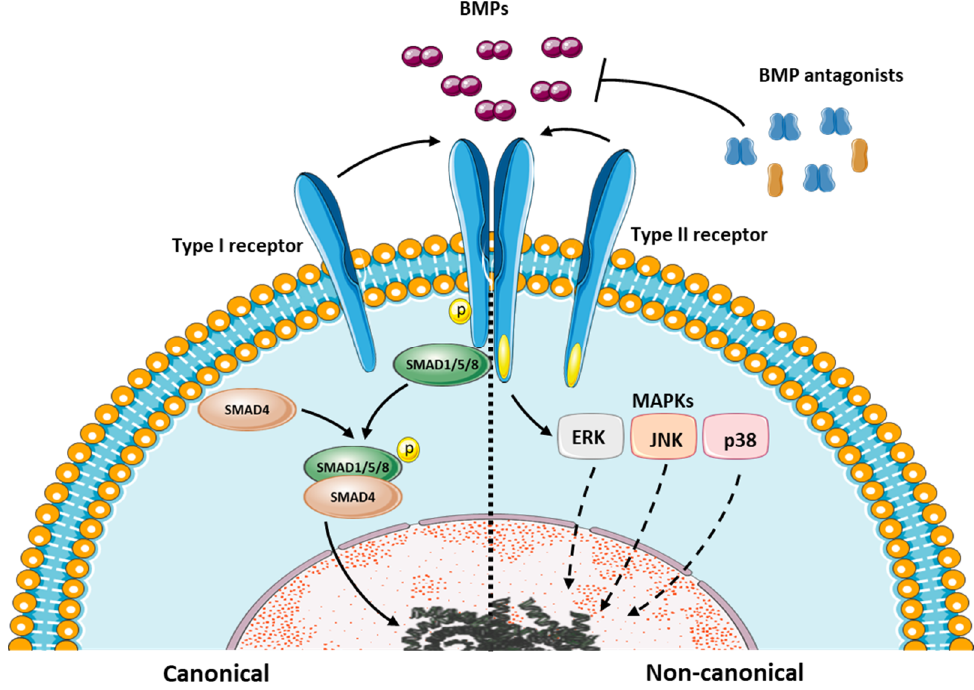
Figure 1. A schematic representation of the bone morphogenetic proteins (BMP) signaling cascade. BMP antagonists are important regulators of BMP signaling amplitude as they directly bind BMPs, thereby preventing them from interacting with the receptors.